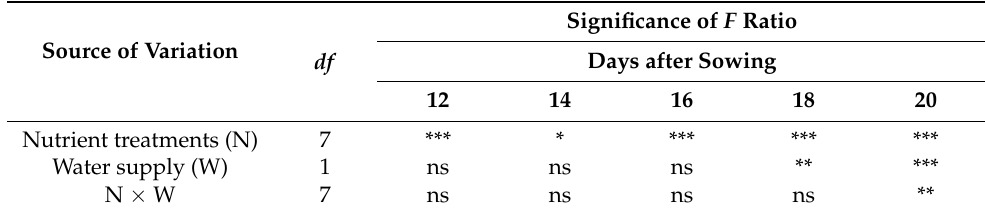
Table 5. Analysis of variance (ANOVA) results for shoot fresh weight (FW) at days 12, 14, 16, 18 and 20 after sowing.